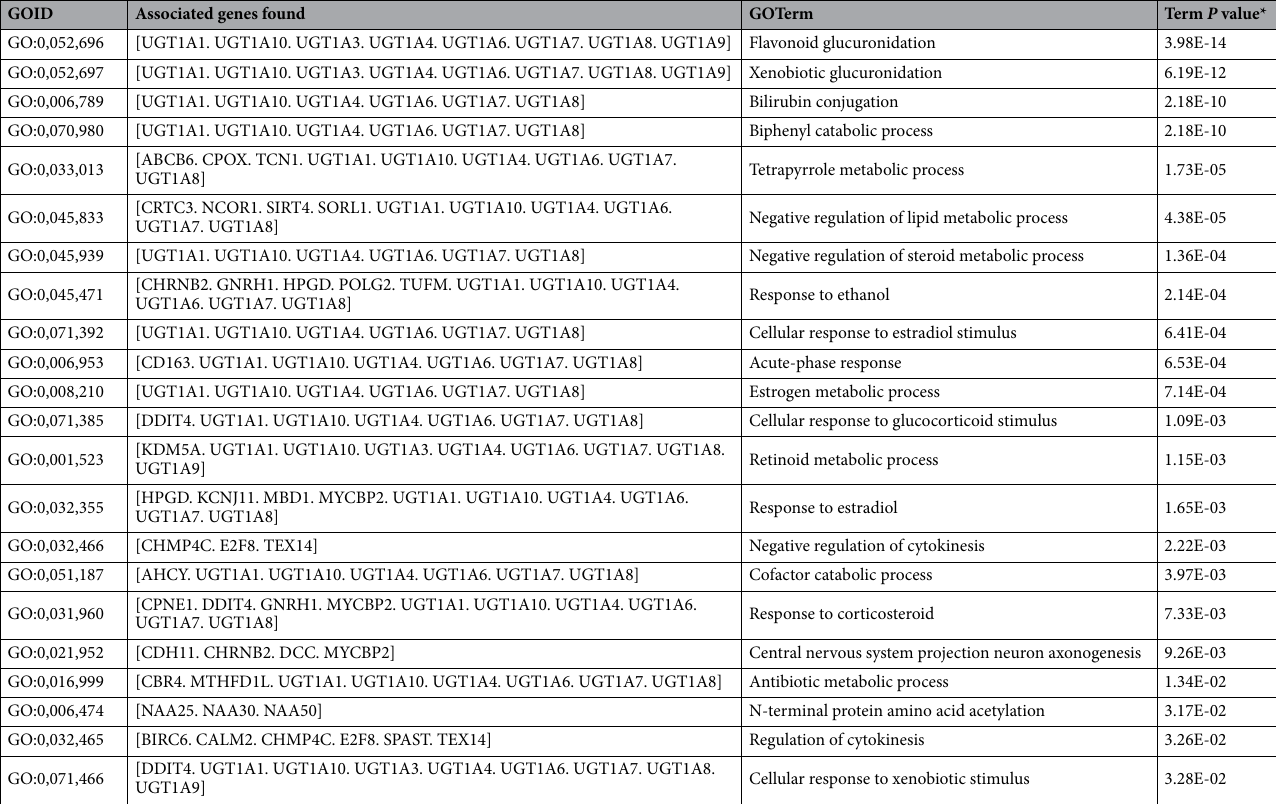
Table 2. Gene Ontology (GO) analysis results of target genes for the most significant differentially expressed miRNAs (DE-bta-miRNAs) between An and pO (FDR < 10exp-6, LogFC >|2|, n = 18). Gene ontology IDs (GO- ID), gene ontology terms (GO-term), associated genes found and corrected p-values as determined by ClueGO (http:// apps. cytos cape. org/ apps/ cluego) are indicated. *Corrected with Bonferroni step down.